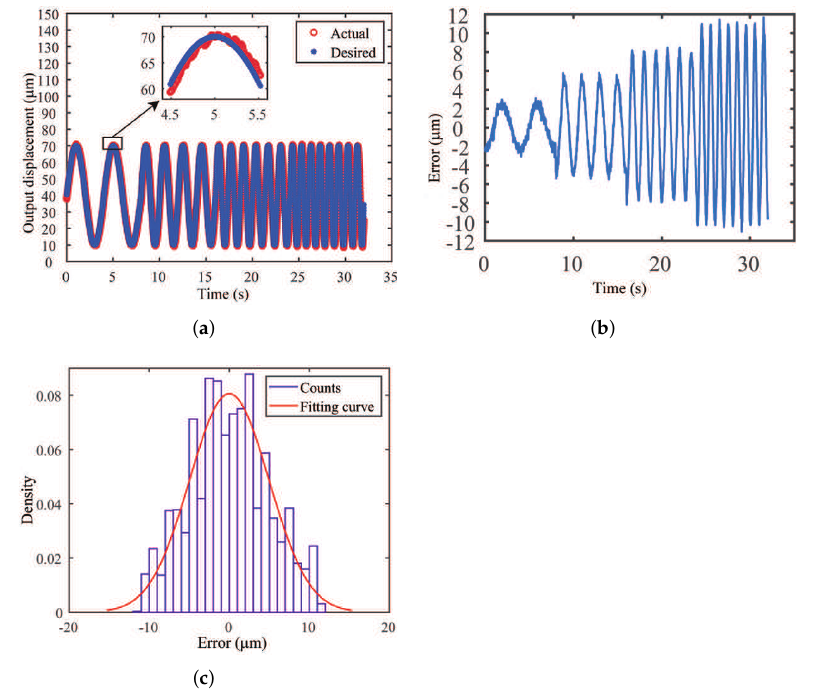
Figure 15. Experimental results of position tracking with PI controller for since wave of varying frequencies. ( a ) Reference and actual displacements, ( b ) position tracking error, and ( c ) histogram of position tracking